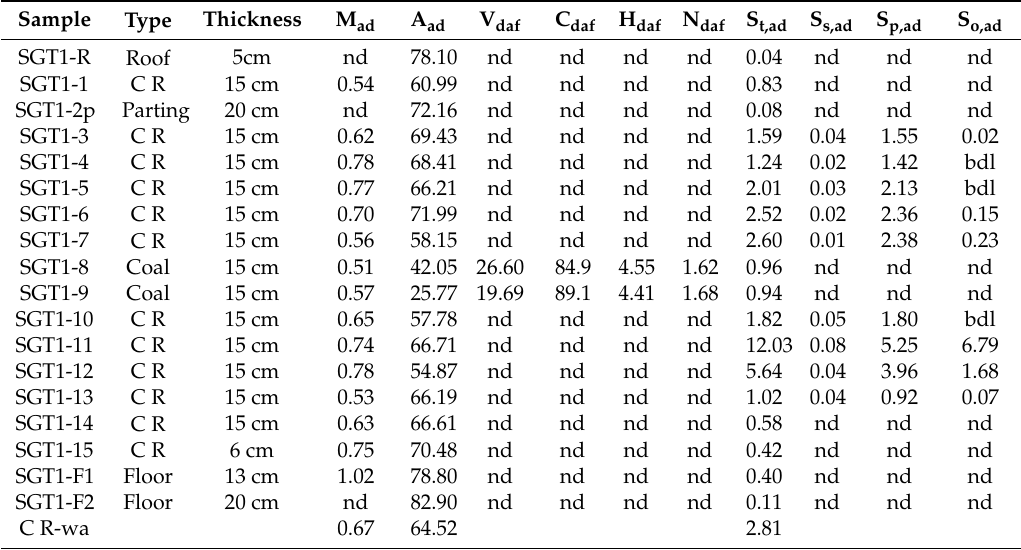
Table 1. Proximate analysis (%), ultimate analysis (%), contents of total sulfur and forms of sulfur (%) of coal, carbonaceous rock, parting, roof and floor samples from 201 drillhole in Shugentian